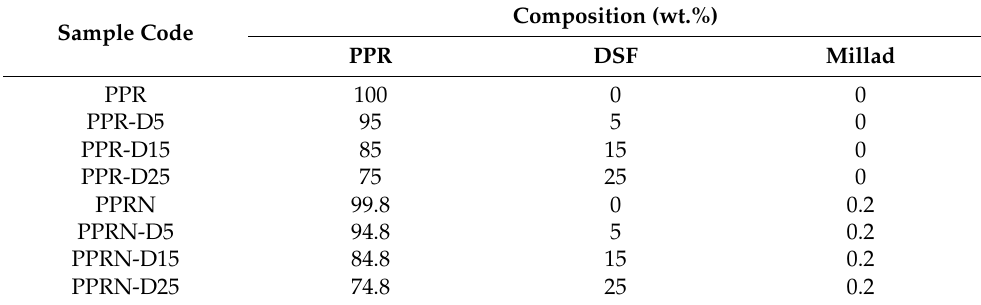
Table 2. Sample code nomenclature and formulations of the different